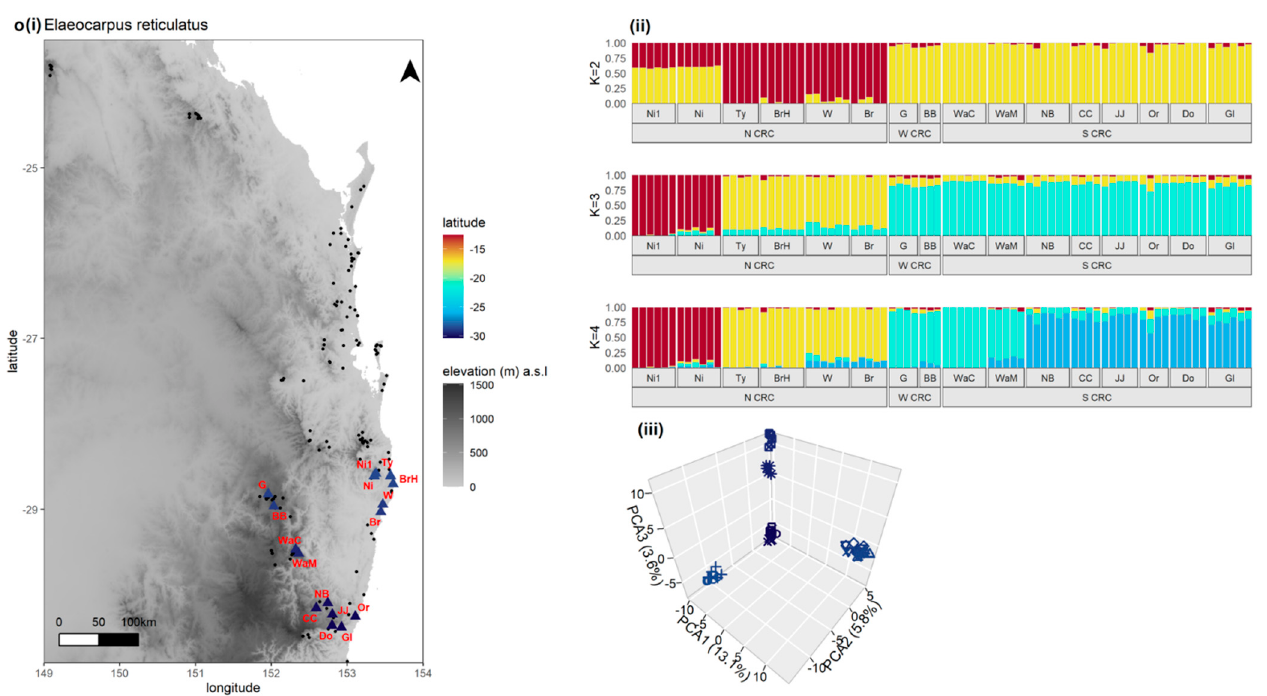
Figure 3. ( a – o ) The 15 study species evaluated for genomic signals of dispersal. For each species, ( i ) the distribution of the species in the study area is indicated by the black circles and the sample sites are coloured according to a latitudinal gradient defined by the extent of the study area. ( ii ) Genotype assignment proportions identified by sNMF, assuming K = 2–4. The sample site and geographic region (or position in relation to a barrier) are indicated by the bottom panel. ( iii ) Principal components analysis of nDNA genomic variance between samples, ordinated by first three primary axes of variation. Samples are coloured according to latitude and shape indicates sample site. ( iv ) Median-joining network of chloroplast haplotypes (epsilon = 0). Circles are proportional to the number of samples per haplotype and coloured by the latitude of the sample site. The number of mutations between haplotypes are in brackets, and the length of nodes are indicative but not directly proportional to number of mutations.